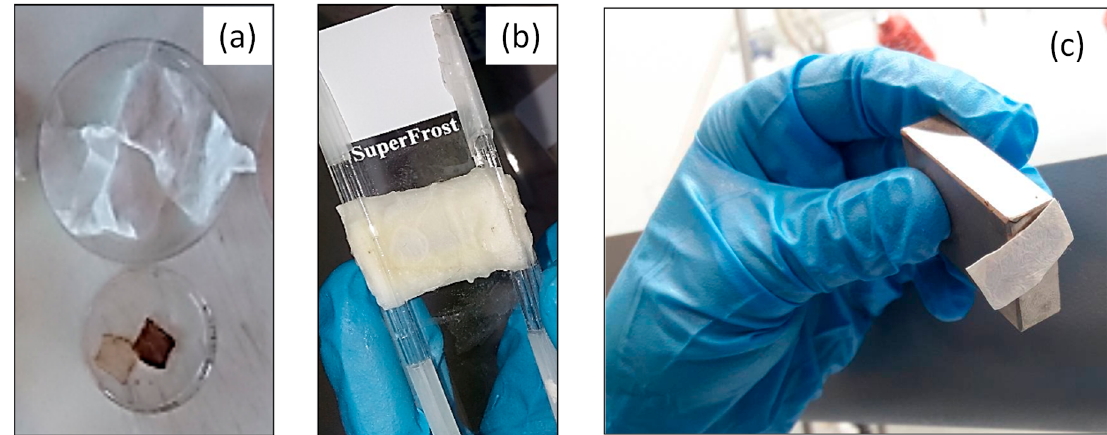
Figure 9. Consecutive preparation steps followed for the generation of cellulose-based white-colored magnetic paper with a sandwiched structure. As-prepared CA electrospun membrane employed as the outer layer and inner MIONP-OAOA _CA magnetic layer ( a ). Wrapping of the magnetic inner layer within the CA outer layer and fixation of the sandwiched structure with glassy rods followed by their placement in between two glass slides ( b ). Magnetic white paper attracted by a permanent magnet ( c ).